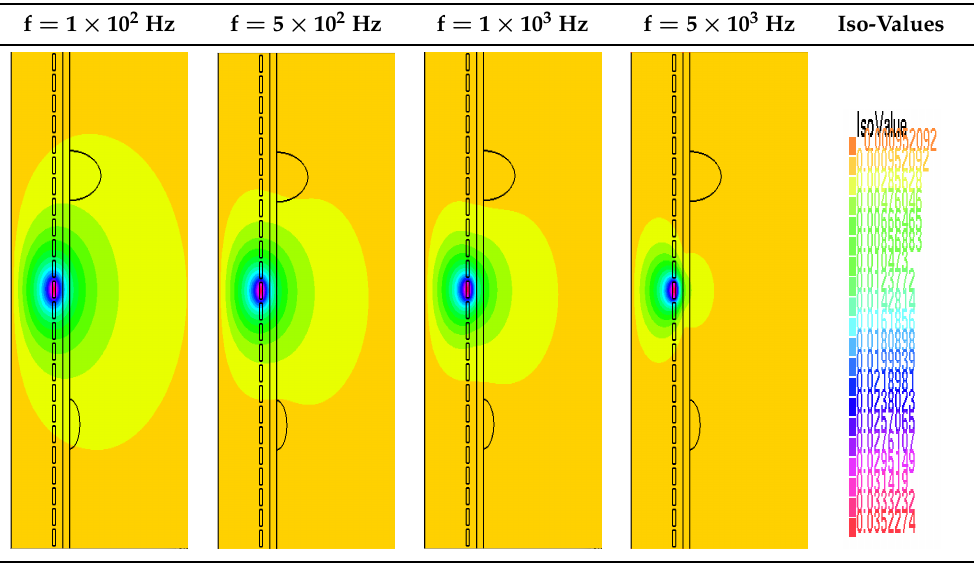
Table 2. Plots of finite element solution of the total field u ( solution to Equation (3)) with excitation from coils for different frequencies.